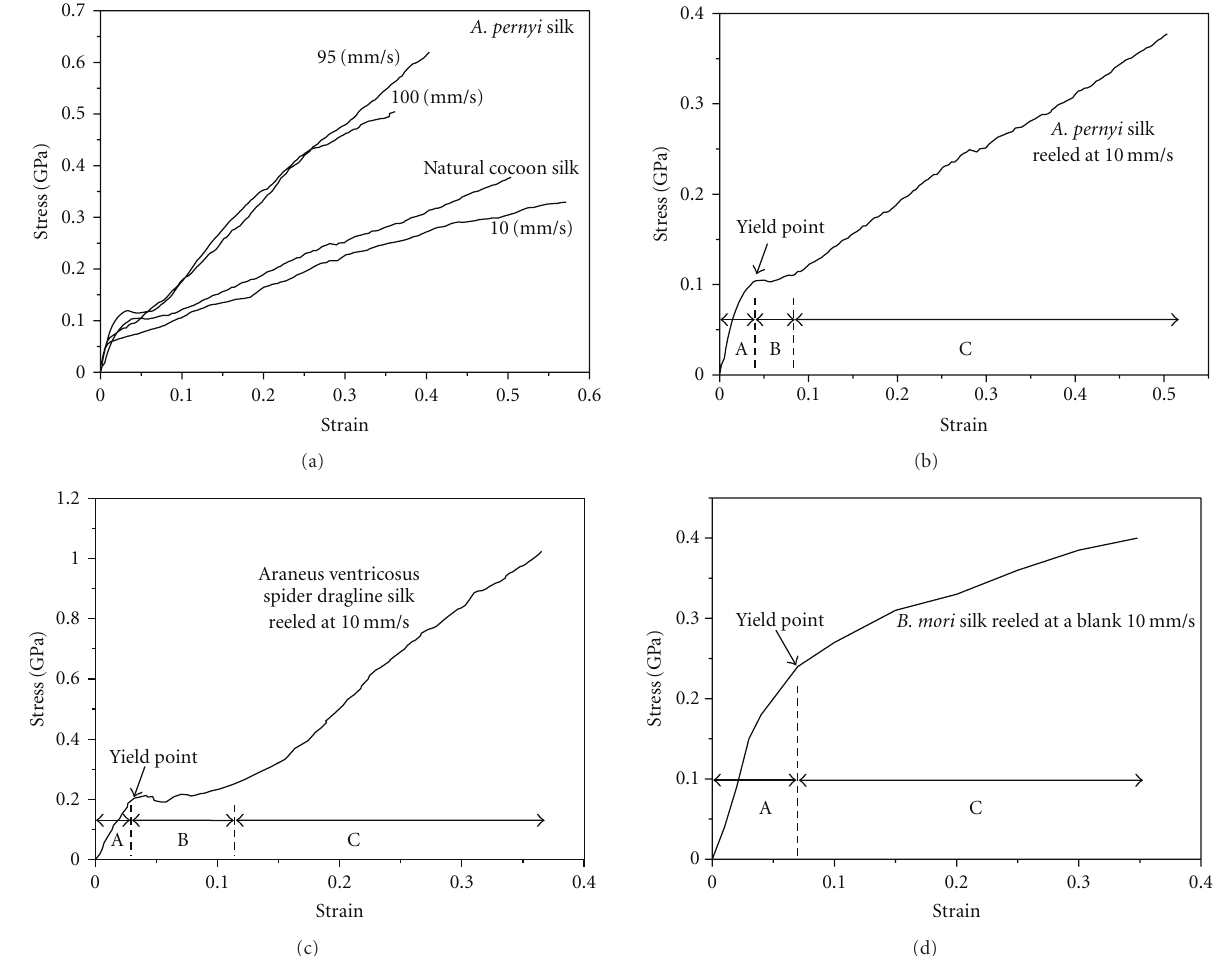
Figure 1: Stress-strain curves of (a) A. pernyi silks obtained at di ff erent spinning speeds, natural cocoon silk of A. pernyi , (b) A. pernyi silk, (c) A. ventricosus spider dragline silk and (d) B. mori silk forcibly reeled at